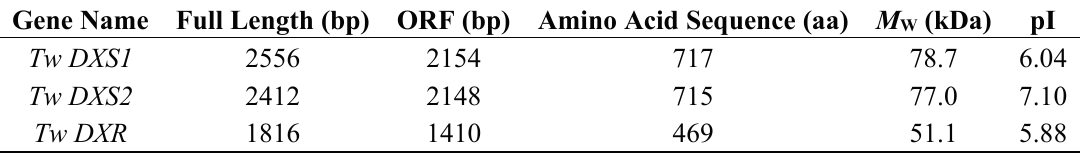
Table 1. Sequence information for DXS and DXR